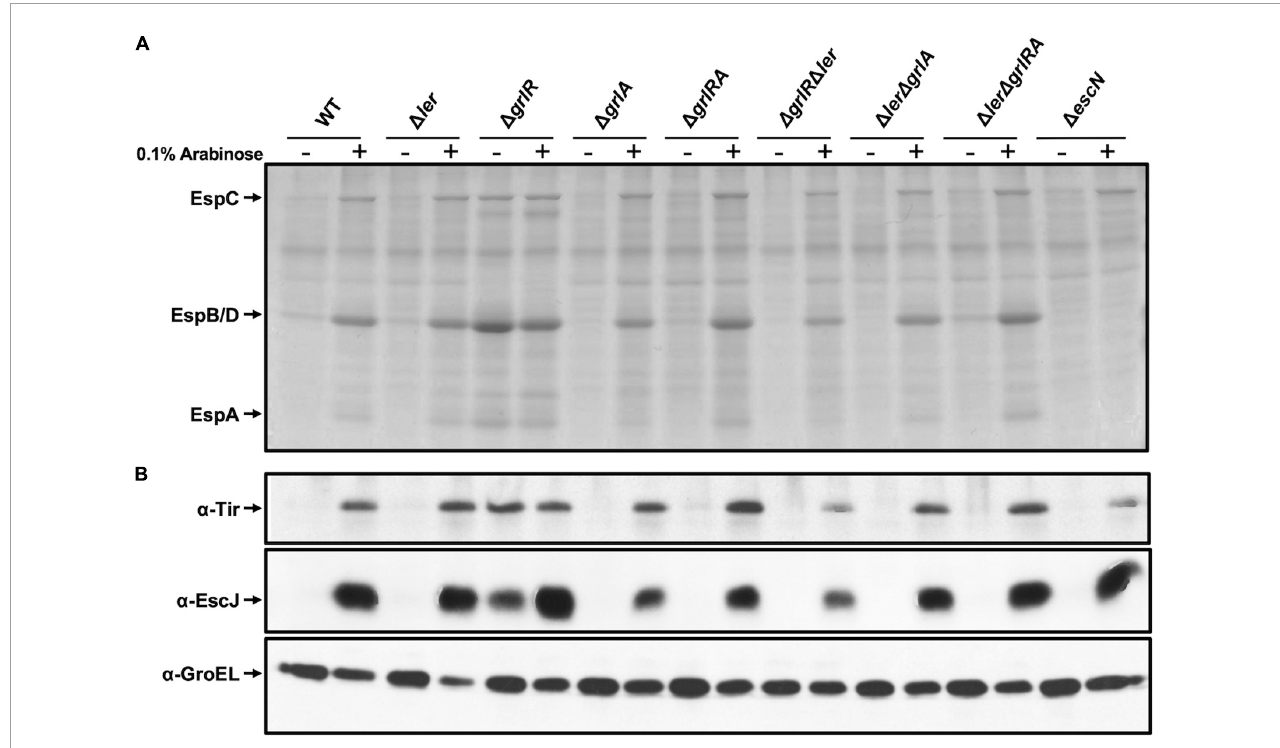
FIGURE5 Protein secretion profile in the presence of a dominant negative H-NS mutant. (A) Secreted proteins from WT enteropathogenic Escherichia coli (EPEC) and its (cid:49) ler , (cid:49) grlR , (cid:49) hns , (cid:49) grlA , (cid:49) grlRA , (cid:49) grlR (cid:49) ler , (cid:49) ler (cid:49) grlA , (cid:49) ler (cid:49) grlRA , and (cid:49) escN derivative mutants, carrying plasmid pT6-HNS/G113D expressing H-NS G113D , grown in 50 ml Lysogeny Broth (LB) with (+) and without (–) 0.1% arabinose at 37 ◦ C with shaking, were concentrated from culture supernatants by precipitation with trichloroacetic acid (TCA), separated by 12% SDS-PAGE and stained with Coomassie brilliant blue. (B) Total extracts were prepared from the corresponding bacterial pellets and separated by 12% SDS-PAGE. Tir and EscJ expression was analyzed by western blotting using an anti-Tir monoclonal antibody and anti-EscJ polyclonal antibodies. As a control for protein loading, GroEL expression was also analyzed using an anti-GroEL monoclonal